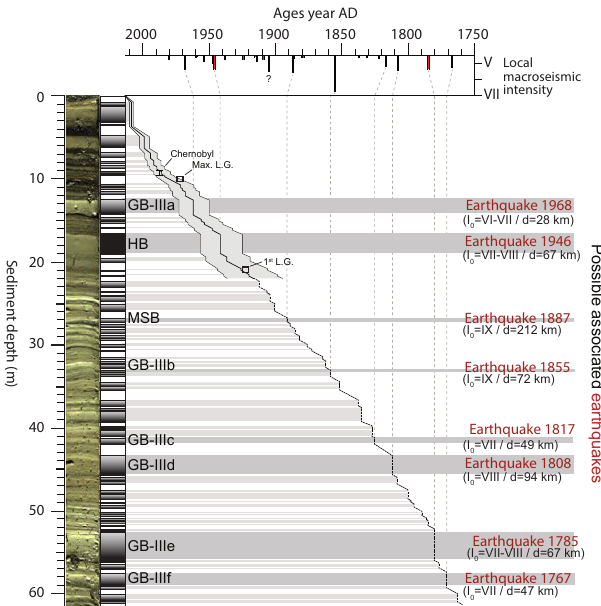
Figure 7. Age–depth relationship of core INF13P3 based on the 210 Pb-based sedimentation rate (with 1 σ uncertainties) for the last century and based on the extrapolation of this sedimentation rate for the lower part of the core. The three chronological markers supporting the 210 Pb-based sedimentation are shown: the 137 Cs peak associated with the Chernobyl accident (1986), the first use of leaded gasoline (1920s) and its maximal use (1970s). Labels (GB- III, HB and MSB) correspond to the mass-movement-induced de- posits. Historical earthquakes, possibly associated with these mass- movement-induced deposits, are indicated with their respective epi- central MSK intensity ( I 0 ) and their distance to the lake ( d ). The up- per panel represents the seismic intensity triggered by the strongest and/or closest historical earthquakes in the lake